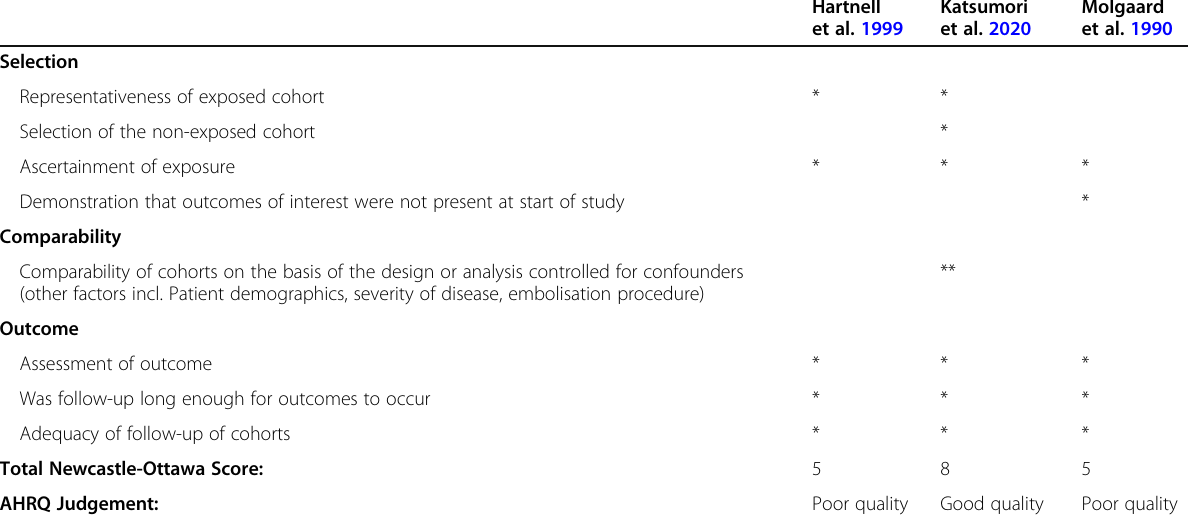
Table 3 A table summarising the Newcastle-Ottawa Quality Assessment Scale judgements made for the cohort studies included in this